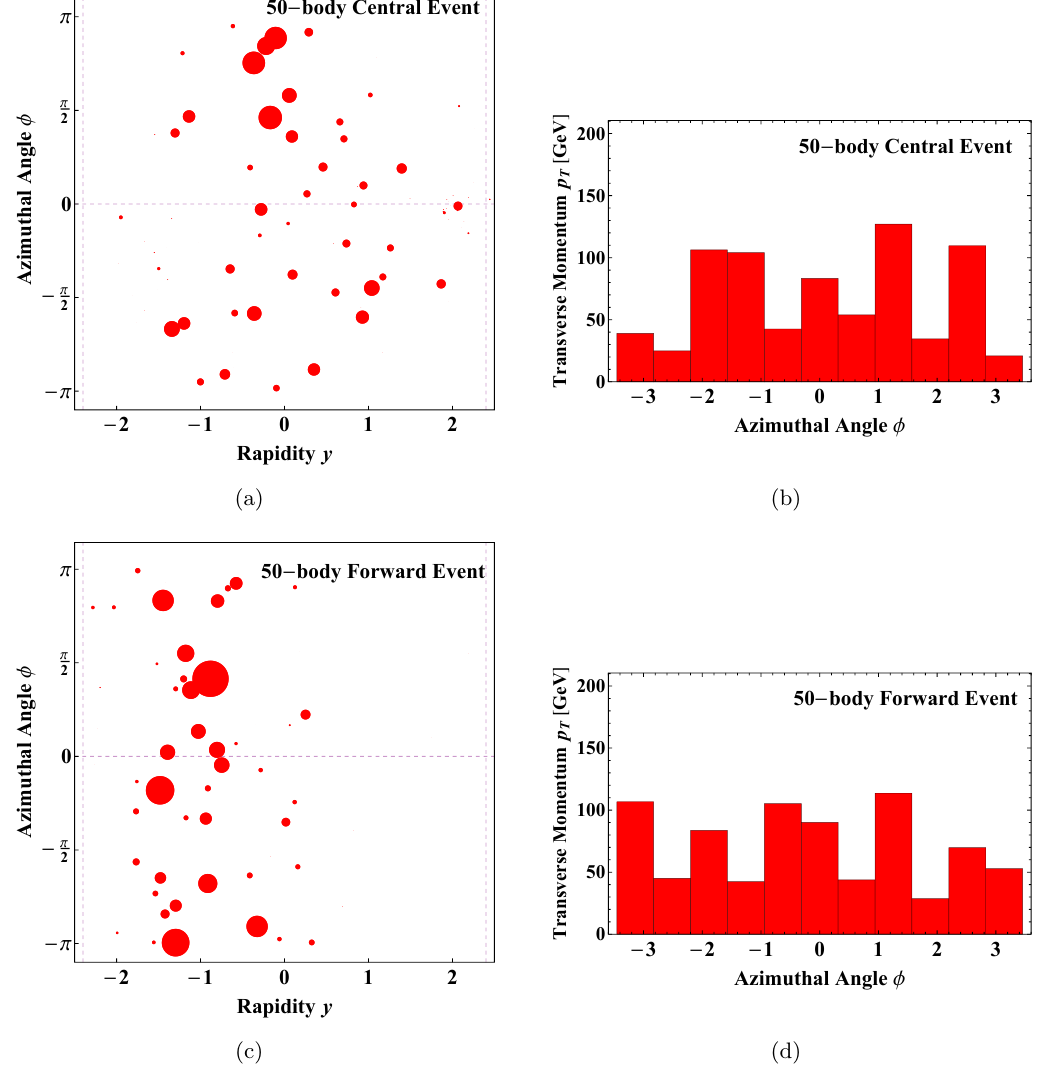
Figure 18 . Two uniform 50-body phase space events from pp collisions, in (left column) the rapidity-azimuth plane where the size of the marker corresponds to the p T of the particle and (right column) projected to the azimuthal direction. The distributions in azimuth are reasonably isotropic in both events. The (cid:12)rst event (top row) is centered in rapidity, while the second event (bottom row) is longitudinally boosted with the particles clustered to one side of the